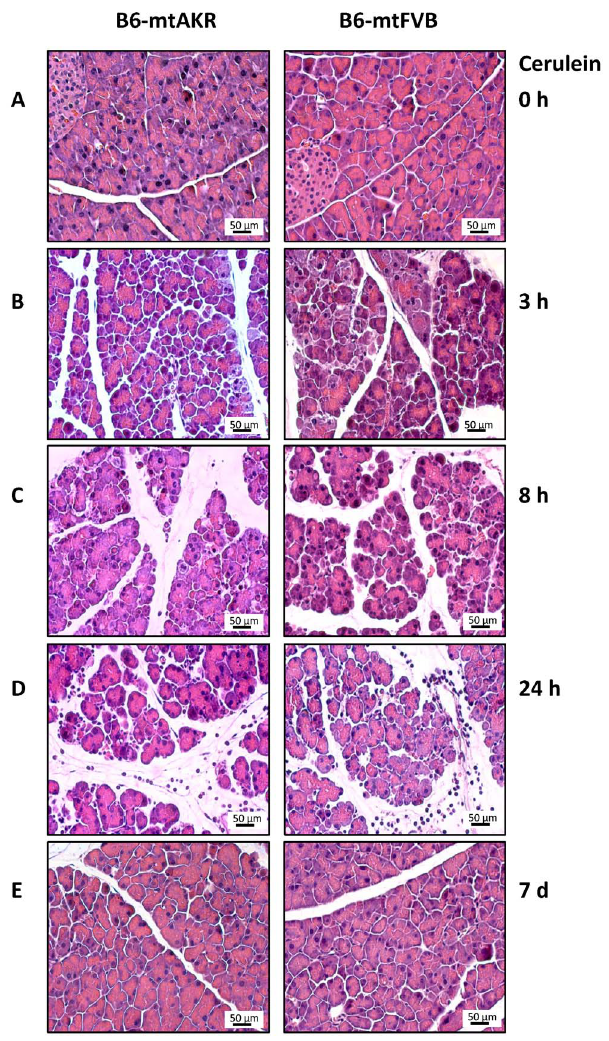
Figure 1. Pancreatic histopathology of cerulein-treated and untreated 12-month-old B6-mtAKR and B6-mtFVB mice. Pan- creatic sections were stained with H&E. Photographs A–E display representative examples of pancreatic damage at the time points 0 h, 3 h, 8 h, 24 h and 7 days after the start of cerulein treatment. Left panel: B6-mtAKR mice, right panel: B6-mtFVB mice. The following description of pancreatic histopathology refers to both strains, since major differences were not observed: (A) 0 h – healthy pancreatic tissue (B) 3 h and (C) 8 h – progressive interstitial edema, accompanied by cell swelling, vacuolization and cystic degeneration; death of single cells (D) 24 h – interstitial edema, cell degeneration and multiple apoptotic and necrotic cells; presence of scattered interstitial inflammatory cells (E) day 7 – largely healthy pancreatic tissue. All photographs show selected regions without lymphocytic